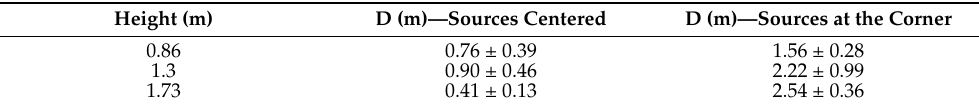
Figure 24. EJ-200 scintillator gamma-ray count rate (cps) measurements obtained using the detection system integrated in the drone considering 137 Cs sources of 4 MBq positioned at the bottom corner of the container. The distance “D” between the real sources position and the estimated position (MLE algorithm) is also given. Drone trajectories were performed at: ( a ) one-third the container height. ( b ) half the container height. ( c ) two-thirds the container height. Table 8. Average and SD of the distance (D) between the estimated position of the source (using MLE algorithm) and the true source position using the gamma-ray counts of EJ-200 detector considering 137 Cs sources of 4 MBq placed at the center and bottom corner of the shipping container.